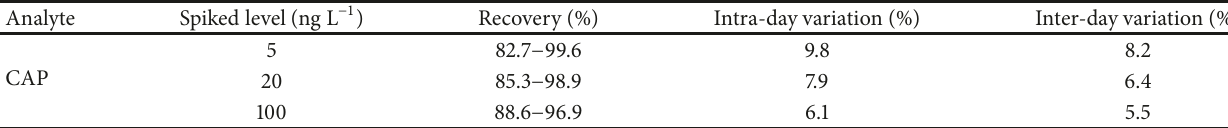
Table 3: Accuracy and precision of CAP in spiked cosmetic